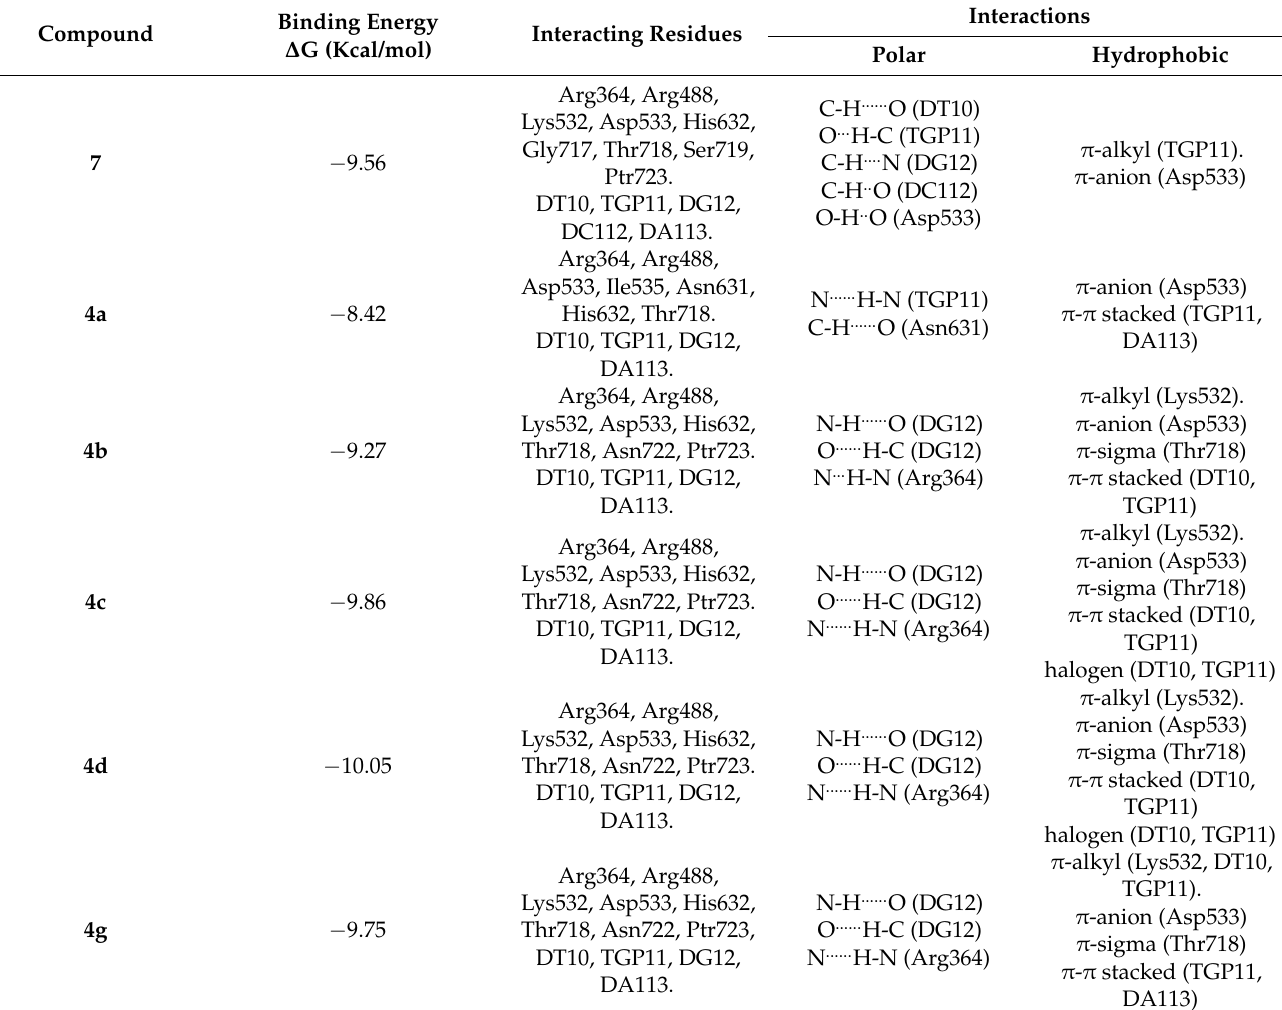
Table 6. Binding energy and interactions of the 2-amino-3-cyano-6,7-methylendioxy-4 H -chromenes 4a–d and 4g and topotecan ( 7 ) at the active site of topoisomerase I (PDB entry no. 1SC7). Binding Energy Compound ∆ G (Kcal/mol) Interacting Residues